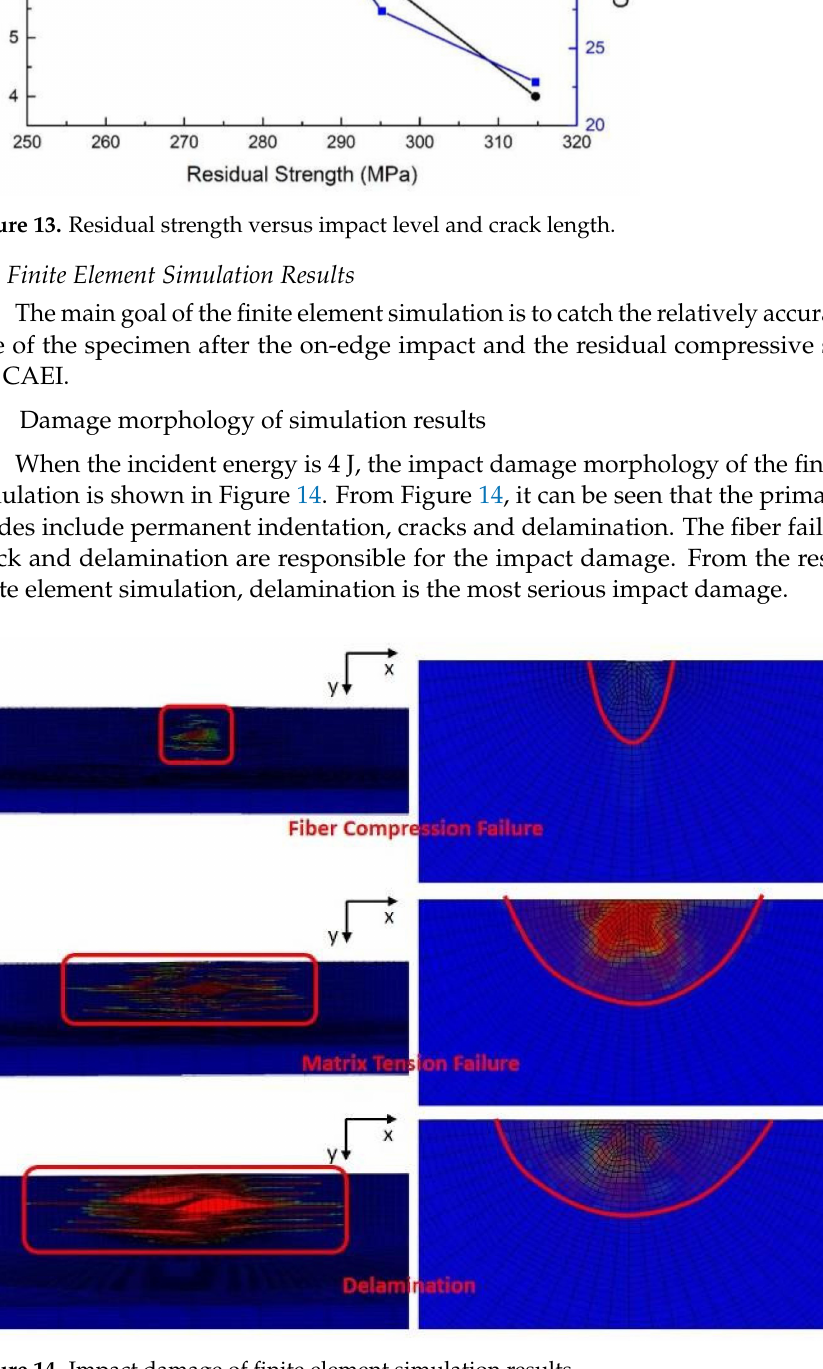
Figure 14. Impact damage of finite element simulation